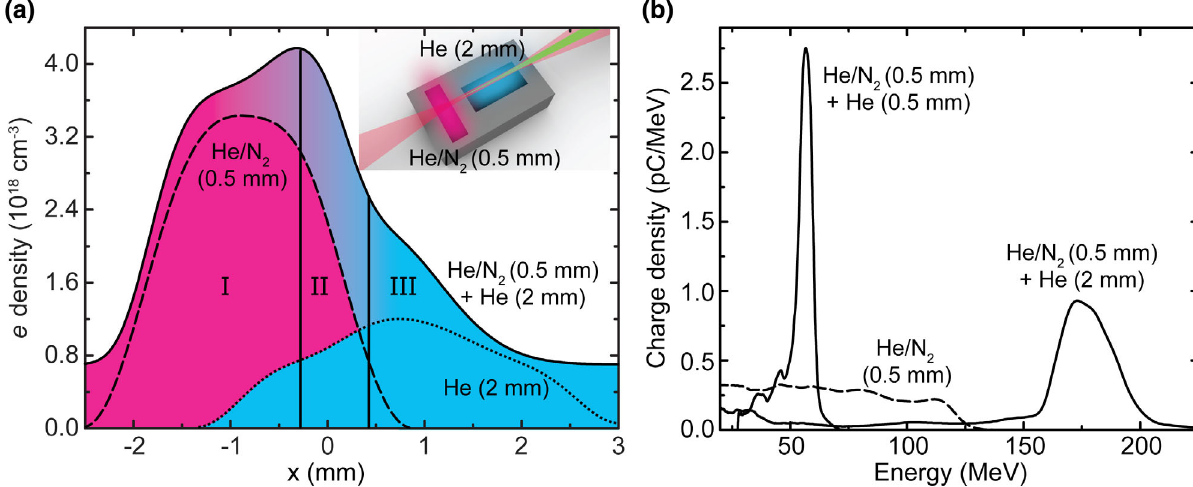
FIG. 1. (a) Gas-target profiles, measured off-line by using tomography, at a height of 2 mm above the nozzle orifices. The concentration of N 2 is represented qualitatively by the colors under the curves. Roman numerals indicate different regions of the optimal composite profile (furthest back in the background), as discussed in the main text. The inset shows the orientation of the laser pulse propagation with respect to the gas target. (b) Examples of e -beam spectra, corresponding to these profiles. Black dashed curve: The first nozzle alone (0.5-mm length, mixed gas, n 1 e ¼ 3 . 4 × 10 18 cm − 3 ). Black dotted curve: The second nozzle alone (2-mm length, helium, n ¼ 1 . 2 × 10 18 cm − 3 ). Black solid curve: Composite profile from both nozzles. In the case of the 2-mm second nozzle, the densities 2 e are the same as above; in the case of the 0.5-mm second nozzle, n 1 e ¼ 2 . 0 × 10 18 cm − 3 and n 2 e ¼ 1 . 5 × 10 17 cm − 3